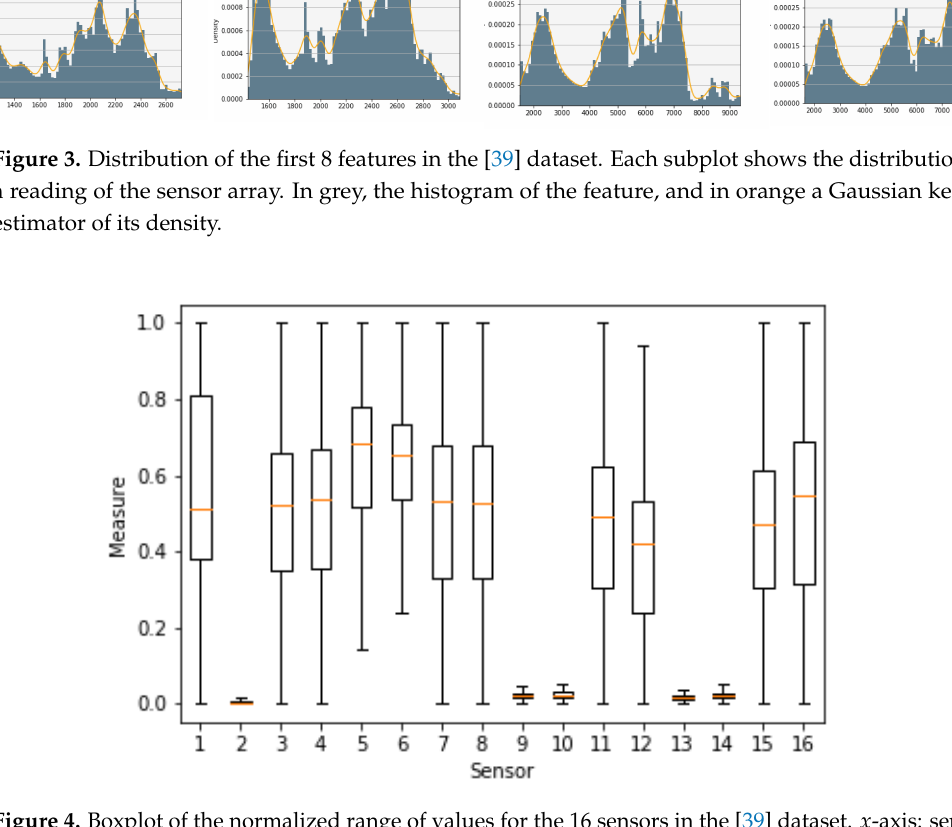
Figure 4. Boxplot of the normalized range of values for the 16 sensors in the [39] dataset. x -axis: sensor id, y -axis: range of